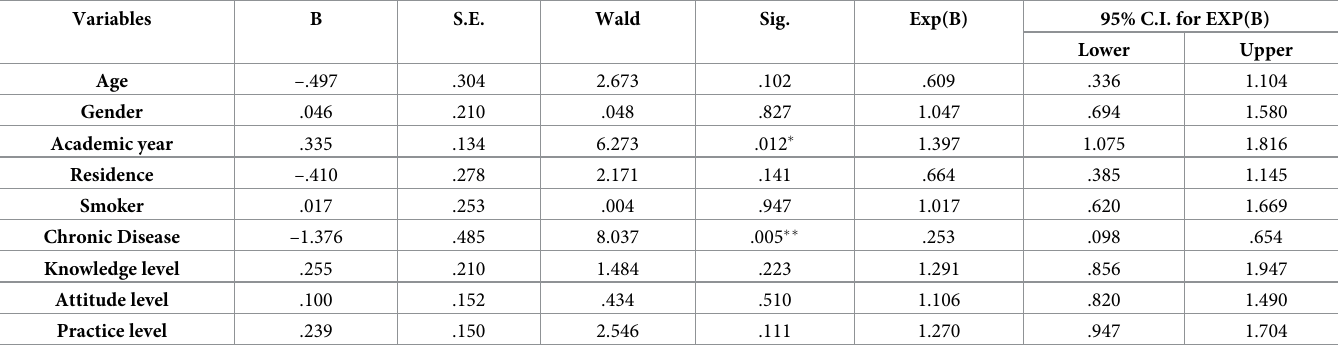
Table 6. Logistic regression of independent predictors of COVID-19 infection status. Variables B